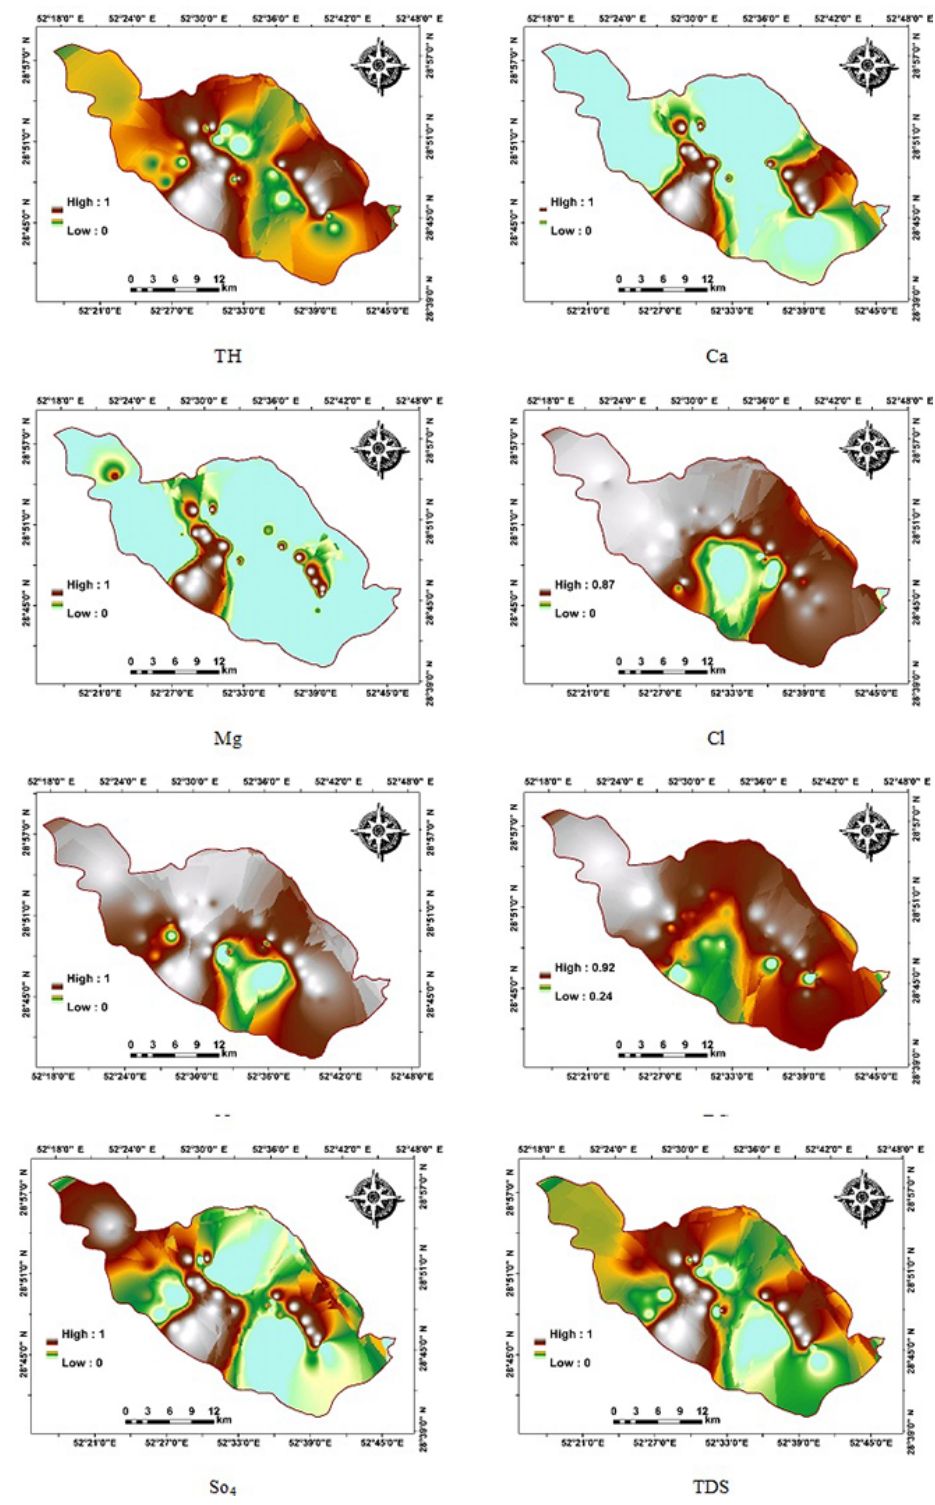
Figure 6. Fuzzy maps of the study area for the drinking water quality based on the content of inorganic component parameters.